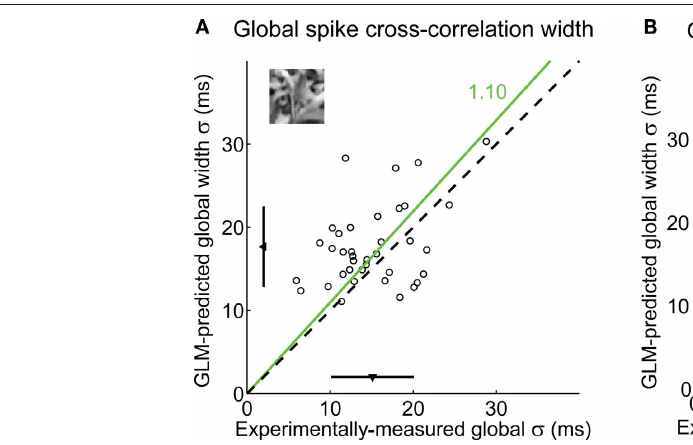
Figure 11 | The gLM globally captures the fine timing precision across cells. (A) Global spike cross-correlation width in response to natural scenes, as predicted by the GLM versus as measured in experimental data (correlation coefficient: r = 0.41). For each pair, the spike cross-correlation width is the standard deviation of the Gaussian that best fits the (global) spike cross- correlation function. A fitted line (green) and the corresponding proportionality coefficient are shown, computed between the cross-correlation width predicted